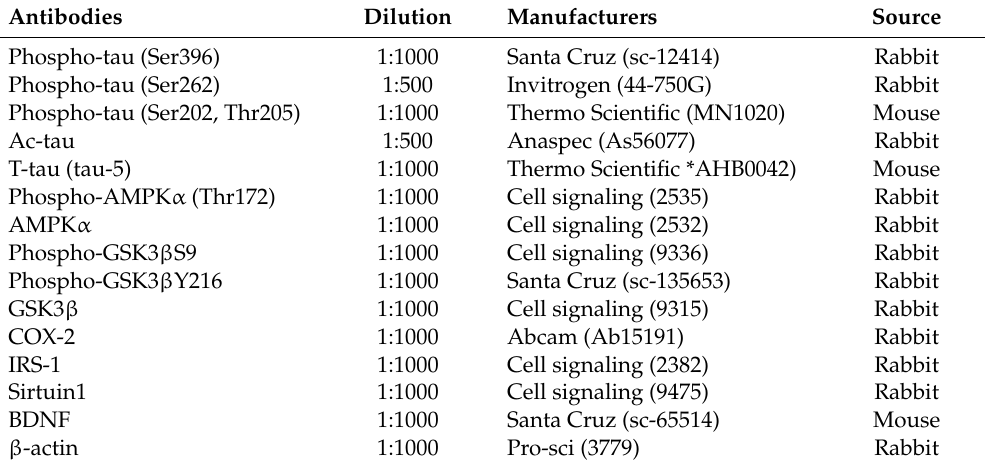
Table 1. List of antibodies used in present